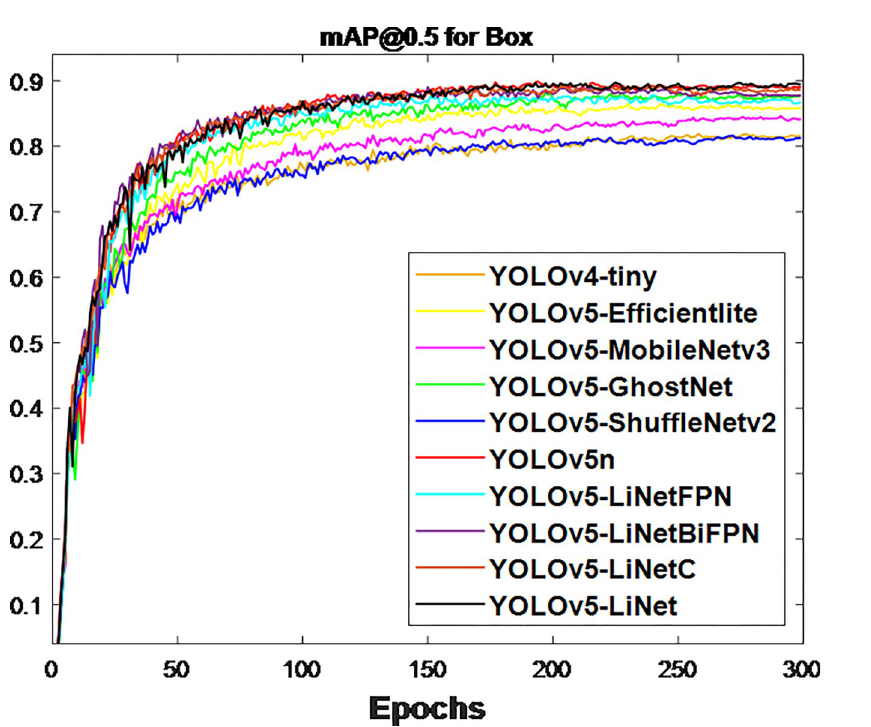
Fig 7. Output for box